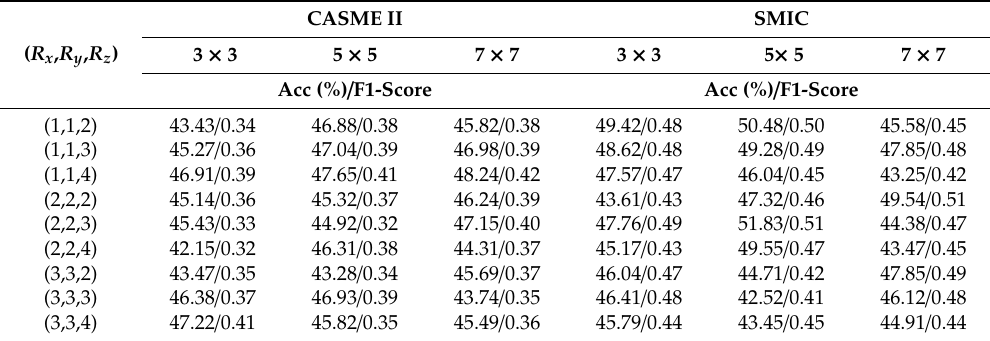
Table 3. The performance of di ff erent uniform LBP-TOP features on CASME II and SMIC. CASME ( R x , R y , R z )